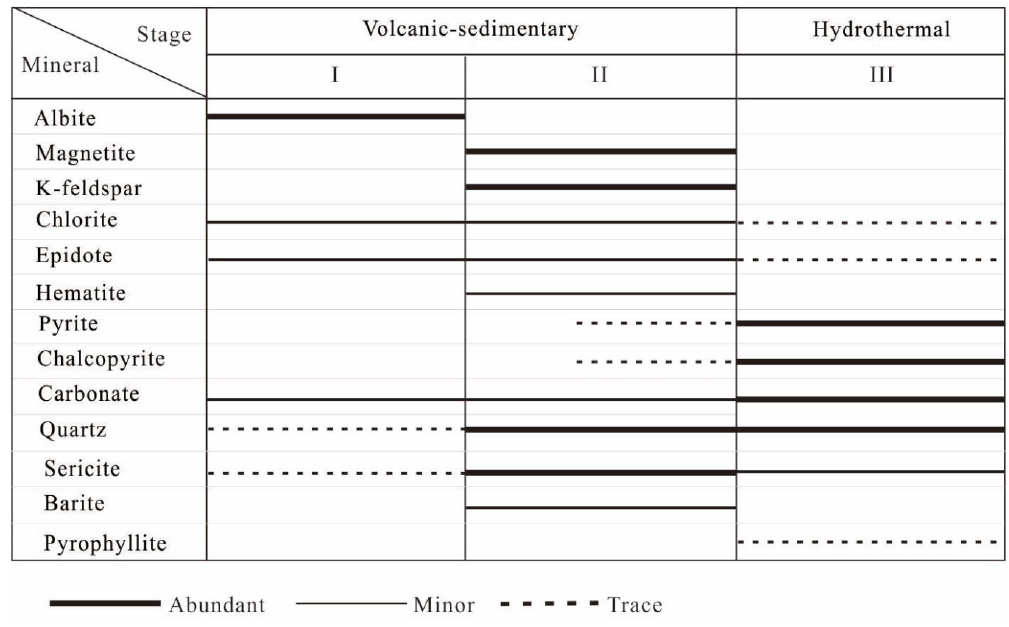
Figure 7. Paragenetic sequence of alteration and mineralization in the Xianglushan Fe-Cu